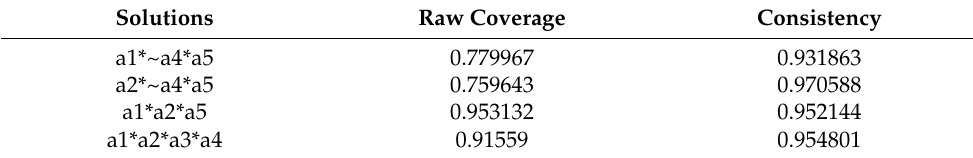
Table A16. Success pathways (ultimate goal)- The mark * resembles “and.”. Solutions